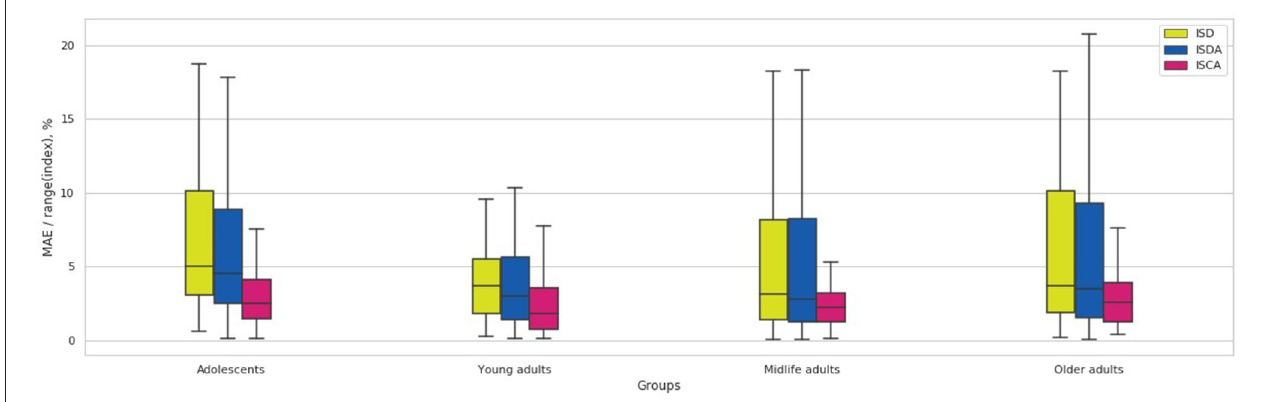
FIGURE 9 | Over-the-age-groups distribution of MAE/range(index) values for Random Forest regression model.